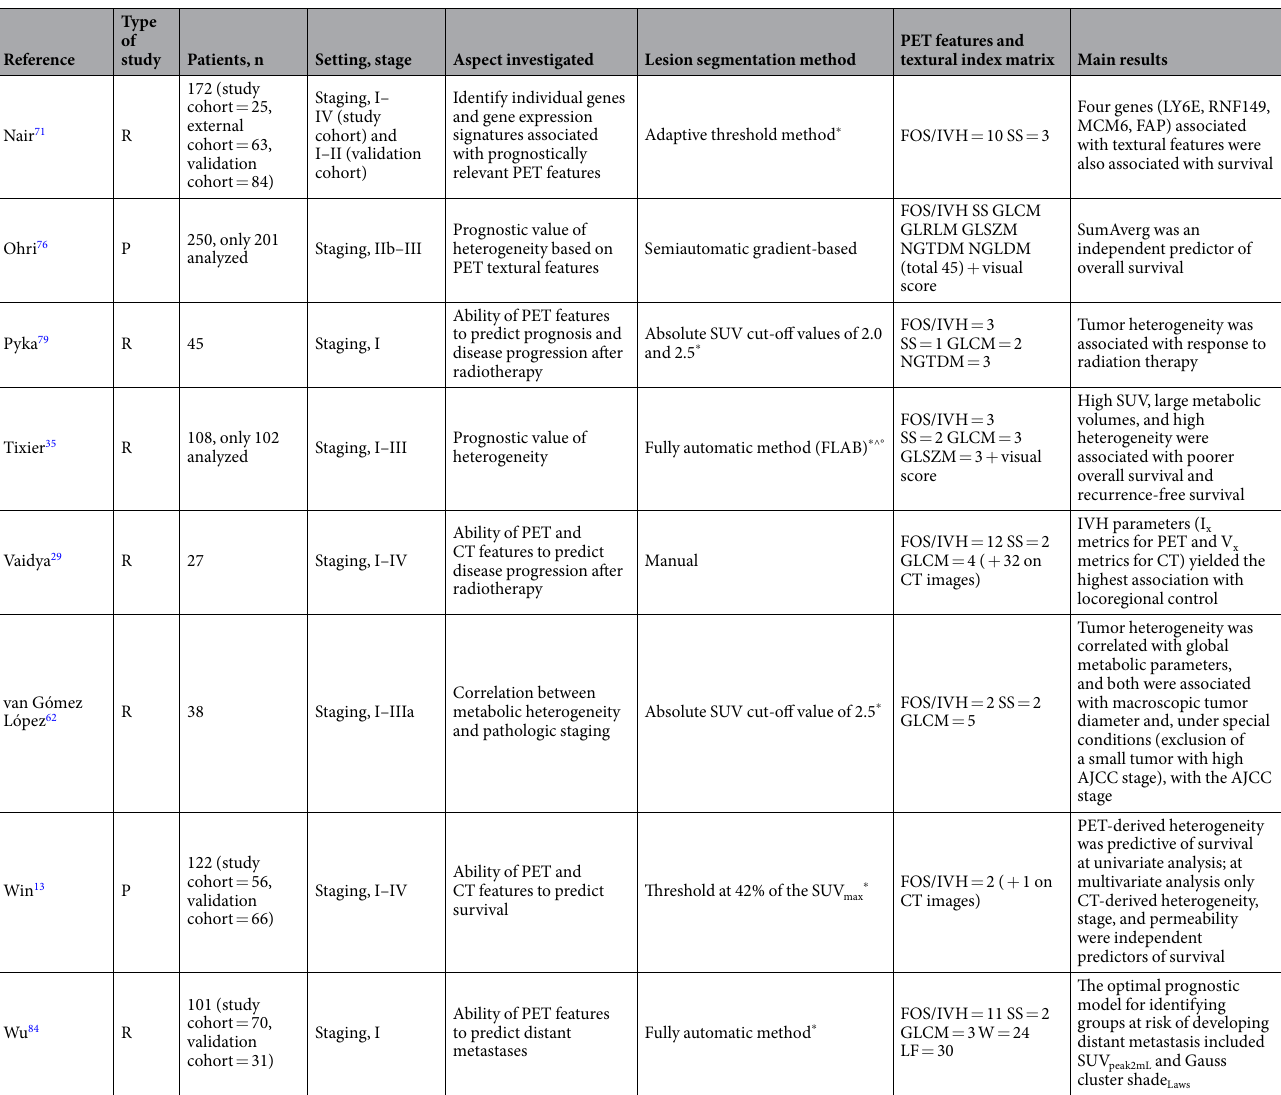
Table 2. Publications reporting studies on the diagnostic, prognostic and predictive role of texture analysis in NSCLC patients. Adk: adenocarcinoma type; FF: fractal features; FLAB: fuzzy locally adaptive Bayesian; FOS/ IVH: first-order statistics/intensity-volume histogram; GLCM: gray-level co-occurrence matrix; GLRLM: gray- level run-length matrix; GLSZM: gray-level size-zone matrix; Gr: absolute gradient; ICC: intra-class correlation coefficient; L: Laplacian; LF: Laws family; n.a.: not available; n.r.: not reported; NGLDM: neighboring gray-level dependence matrix; NGTDM: neighborhood gray-tone difference matrix; P: prospective; R: retrospective; SA: spatial autocorrelation; Sqc: squamocellular types; SS: shape and size; W: wavelet. * Segmentation of only primary lung lesion. # Segmentation of lymph nodes. § Segmentation of primary lung lesion and other tissues (e.g. lymph nodes). ^Application of partial volume correction. °Included in the analysis only lung lesion with a volume > of a minimum cut-off (e.g. 3